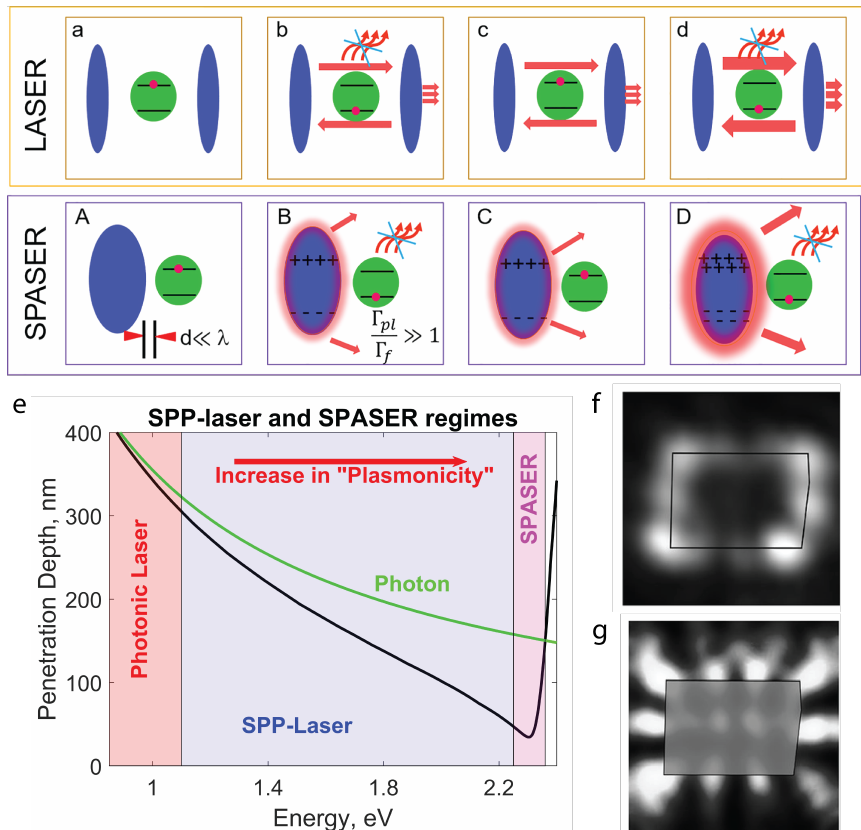
Figure 8. ( a – d ) Key differences and similarities of the conventional laser (top row) and the SPASER (bottom row). The green circle shows an emitter, the top panels show blue mirrors, and the bottom panels show plasmonic metal. ( A ) and ( a ) Excited emitter in the cavity or next to the plasmonic nanostructure at a distance d , much smaller than wavelength λ . ( B ) and ( b ) Spontaneous emission into cavity mode or energy transfer to plasmonic mode, dominating over emission into free space. Γ pl and Γ f are the rate of energy transfer to plasmons and emission into free space, respectively. ( C )